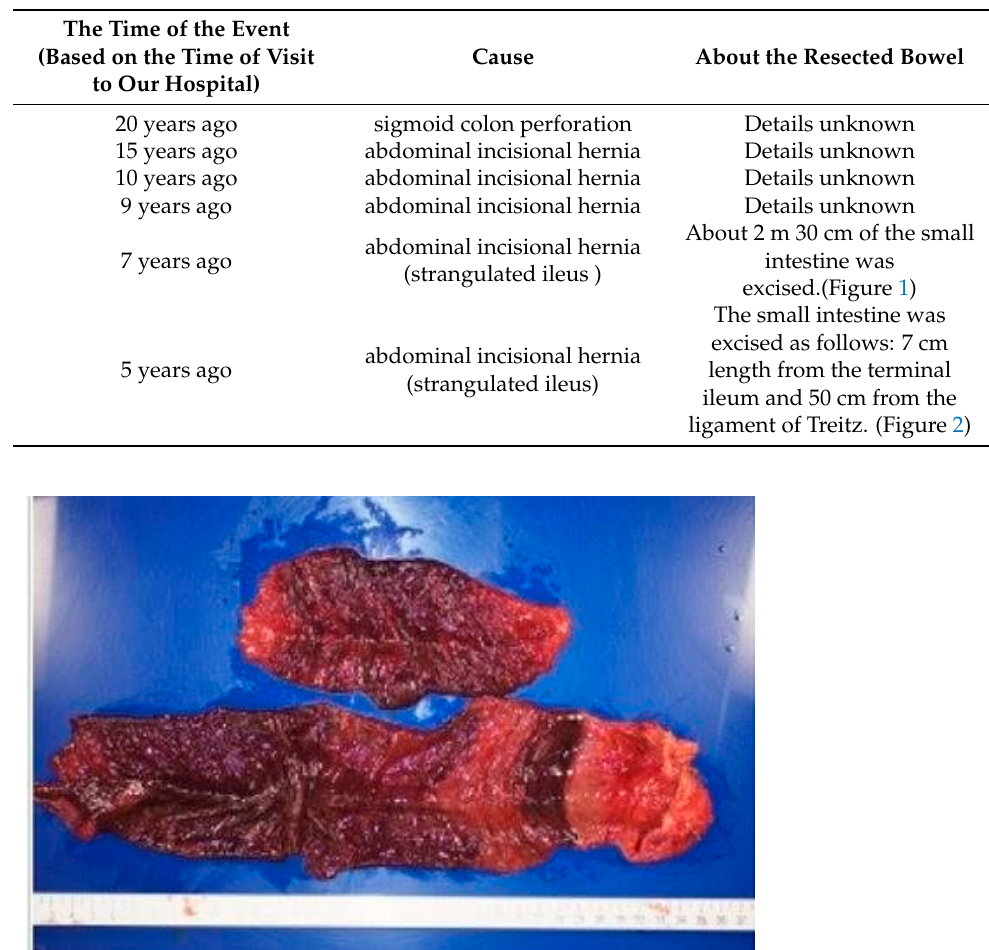
Figure 2. The small intestine was resected as follows: 7 cm from the terminal ileum and 50 cm from the Treitz ligament.